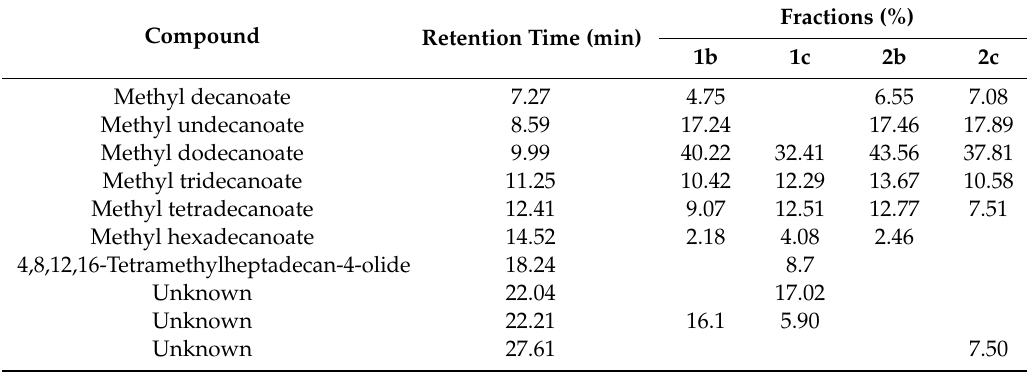
Table 2. Chemical composition found in the methylated fractions of organic extracts from Eugenia winzerlingii leaves by gas chromatography–mass spectrometry (GC-MS) analysis.